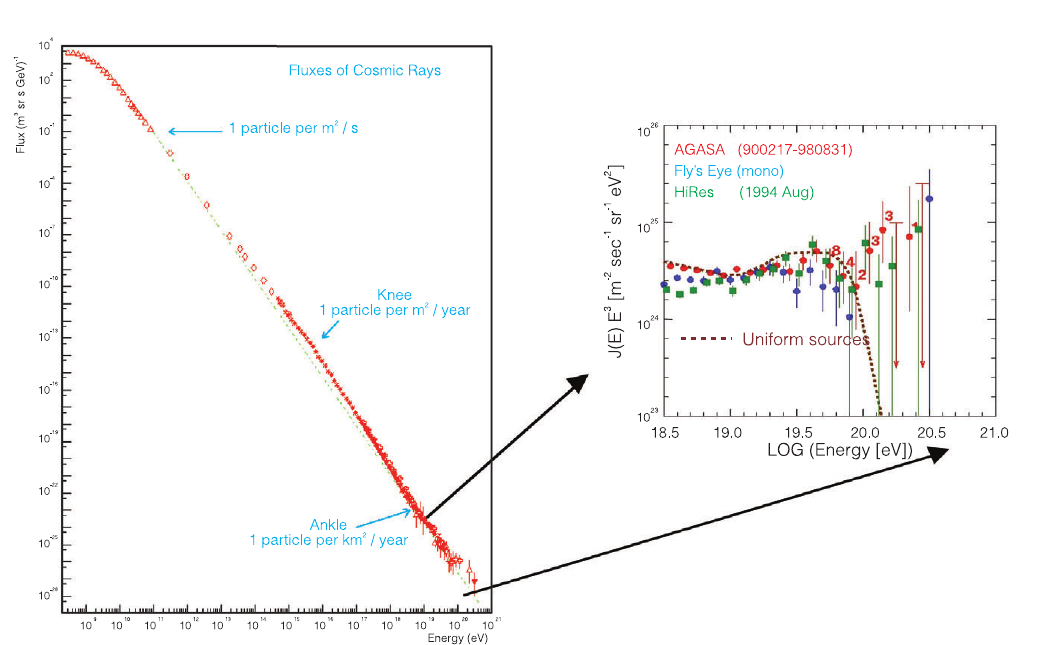
Fig. 1. The observed cosmic ray spectrum for E > 10 8 eV showing the principle features. The inset shows the high-energy part with the overall E -3 dependence removed as observed by AGASA (Takeda et al. , 1998), Fly’s Eye and HiRes. The dashed line shows the effect of the GZK cut-off assuming a homogenous source population fi lling the universe. The numbers are the actual number of events in each bin.